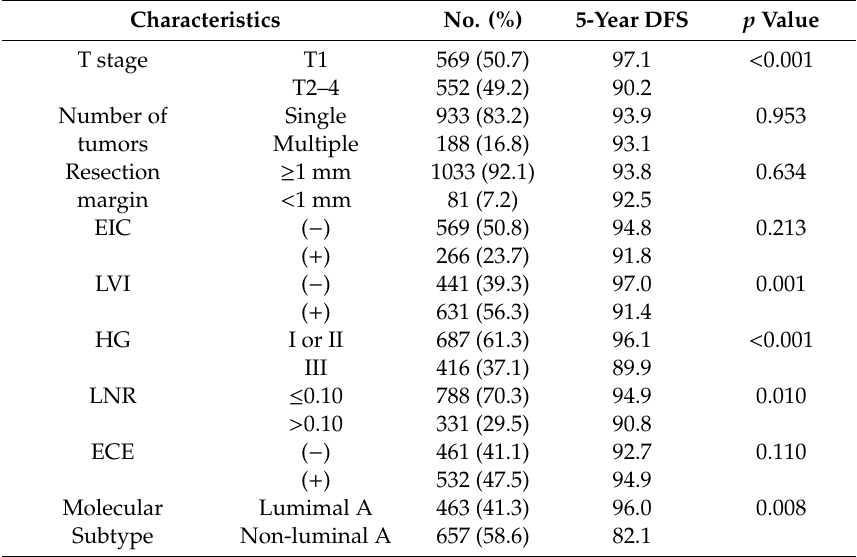
Table 3. Univariate analysis of disease-free